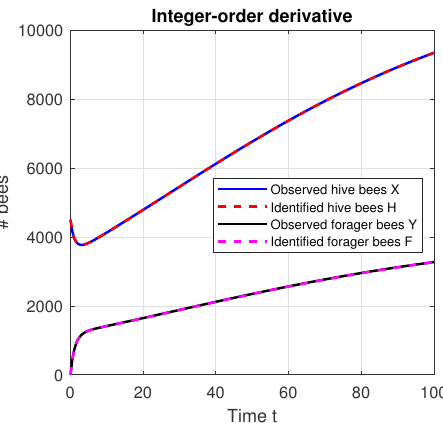
Figure 7. The implied population dynamics with the integer-order derivative model ( r = q =